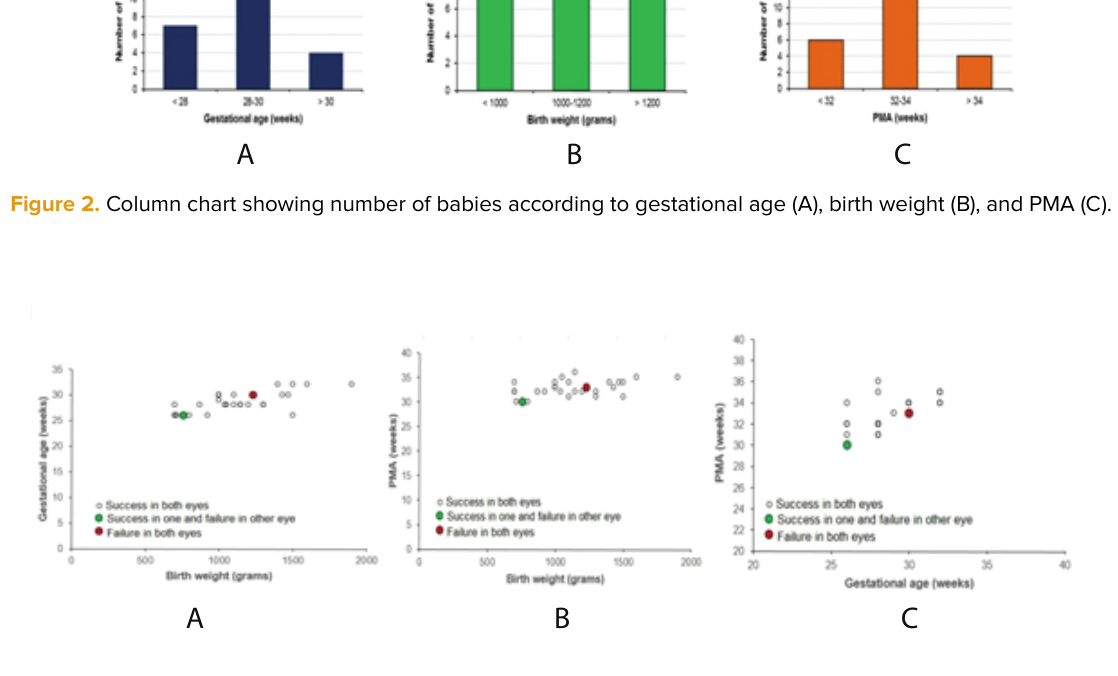
Figure 3. Scatter plot showing success corresponding to birth weight and gestational age (A), birth weight and PMA (B), and gestational age and PMA